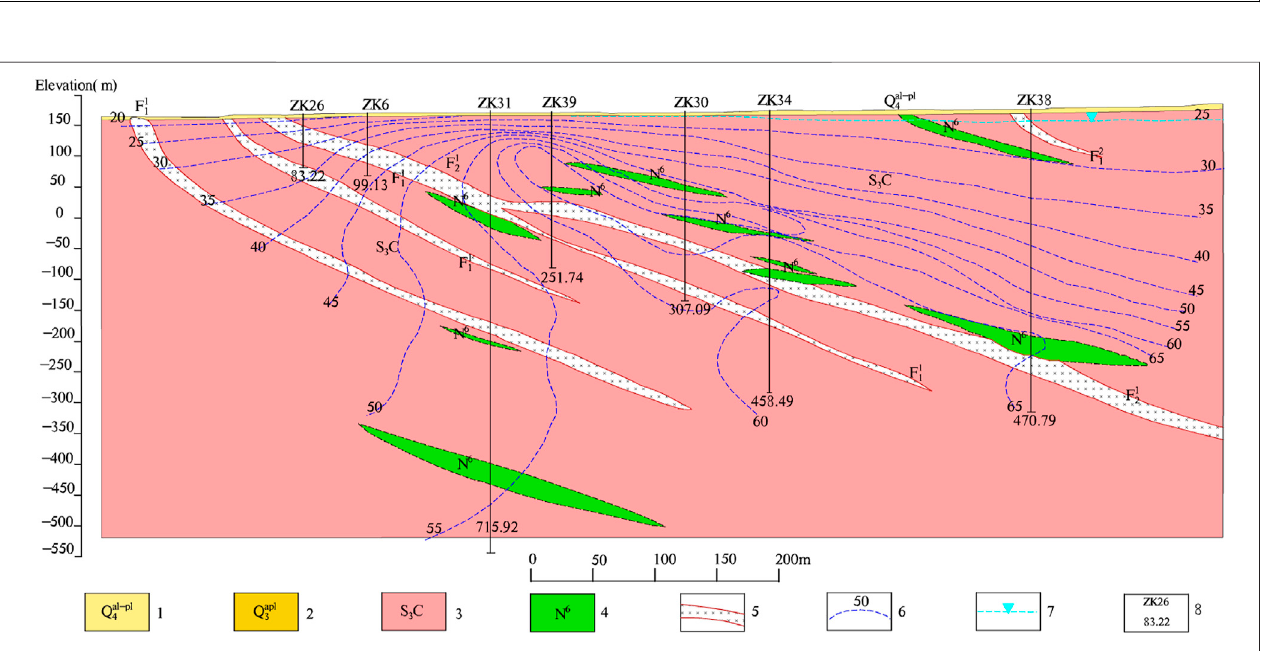
FIGURE3 | Structure pro fi le ofcross section I – I ′ that isplotted in Figure 2 . 1and 2are thesameasin Figure 2 . 3Late Silurian Chouping Unit. 4 Himalayan period diabase. 5 Transtensional Fault (Silici fi ed fracture zone). 6 Isotherm. 7 Geothermal water level. 8 Borehole number and depth.